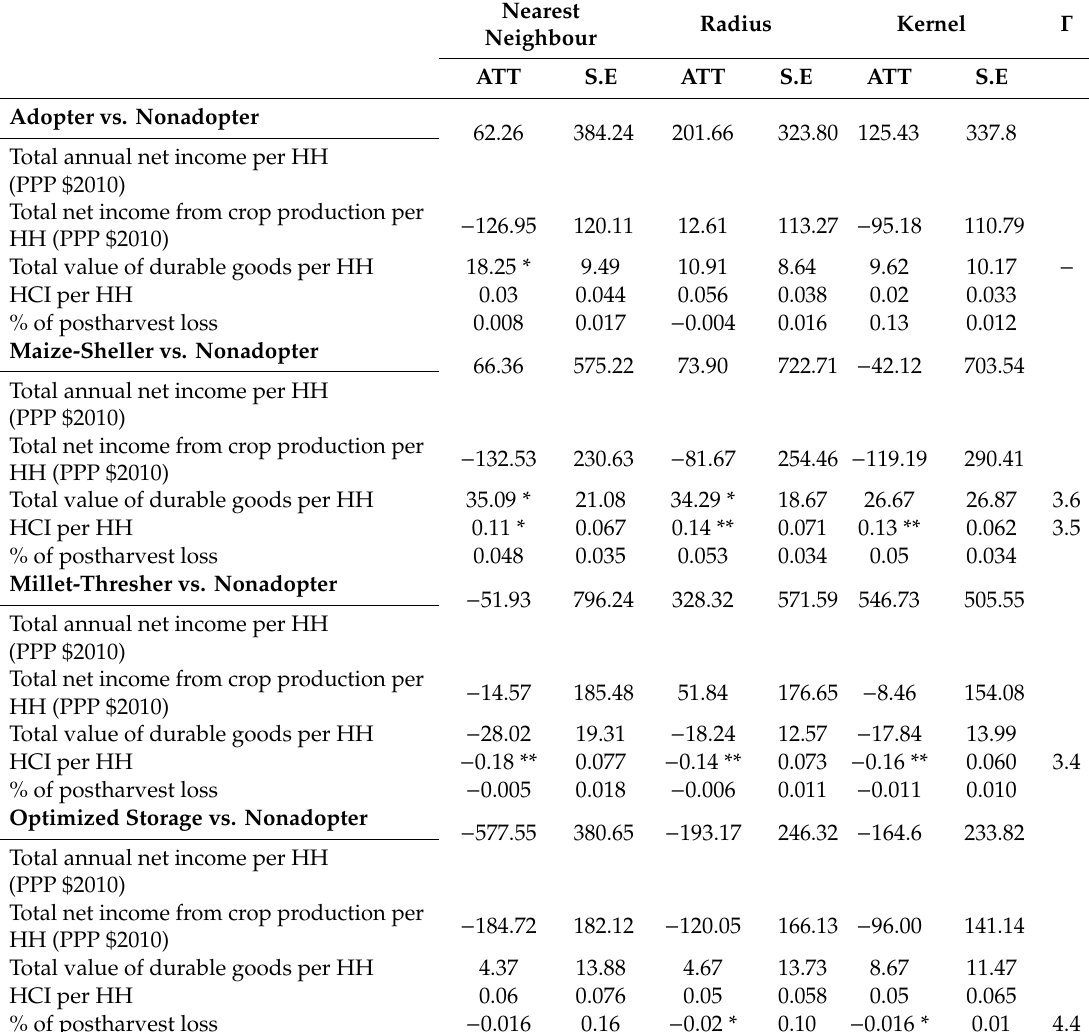
Table 3. Propensity score matching: the impact of UPS adoption on well-being in Tanzania.